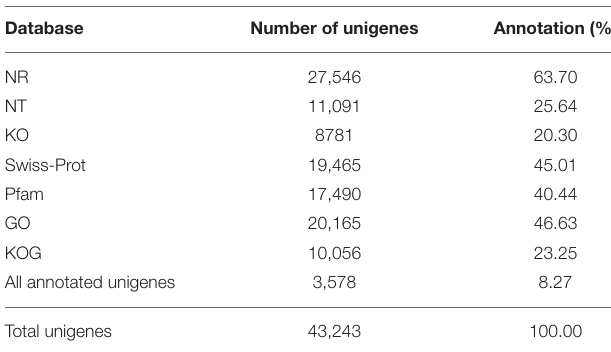
TABLE 2 | Statistics of the annotation percentage of D. asperoides unigenes compared to public